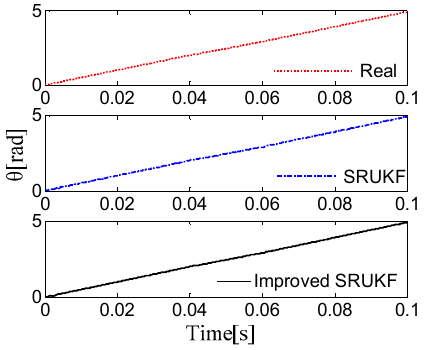
Figure 3. Space position estimation at 50 rad/s.